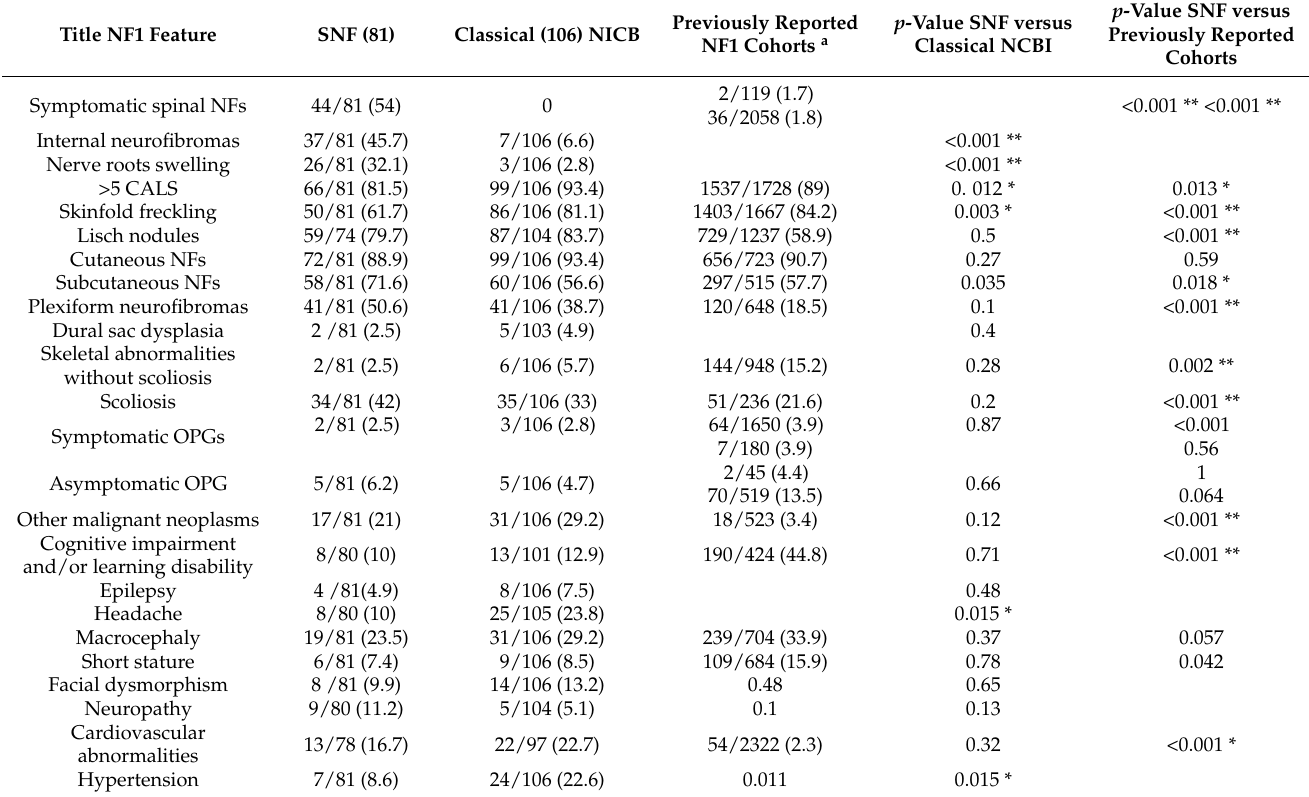
Table 2. Comparisons of clinical characteristics observed in the SNF cohort, the cohort of the “classical” NF1 phenotype from our institutions, and in previously described classical NF1 cohorts from the